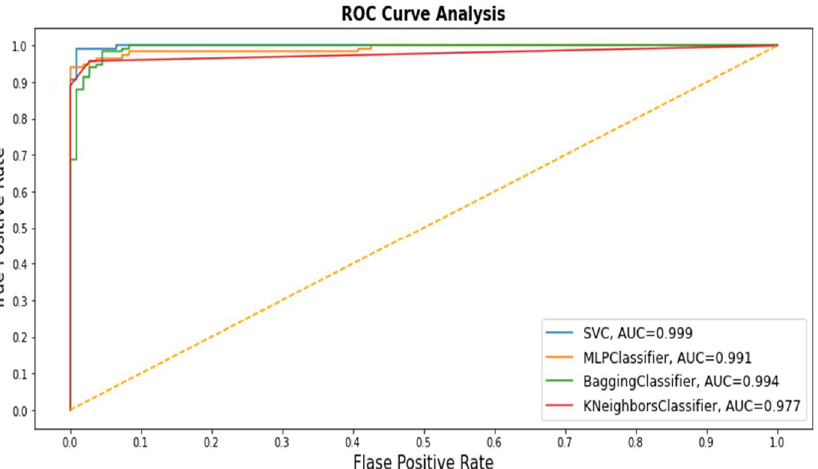
Figure 2. Receiver operating characteristic (ROC) values of all Machine Learning (ML) application models.